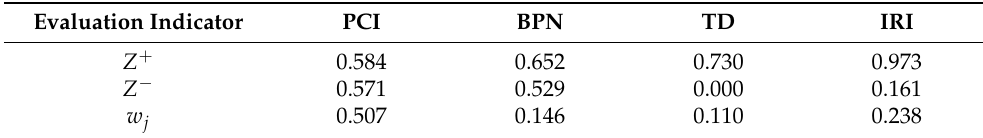
Table 11. Intermediate TOPSIS calculation results.